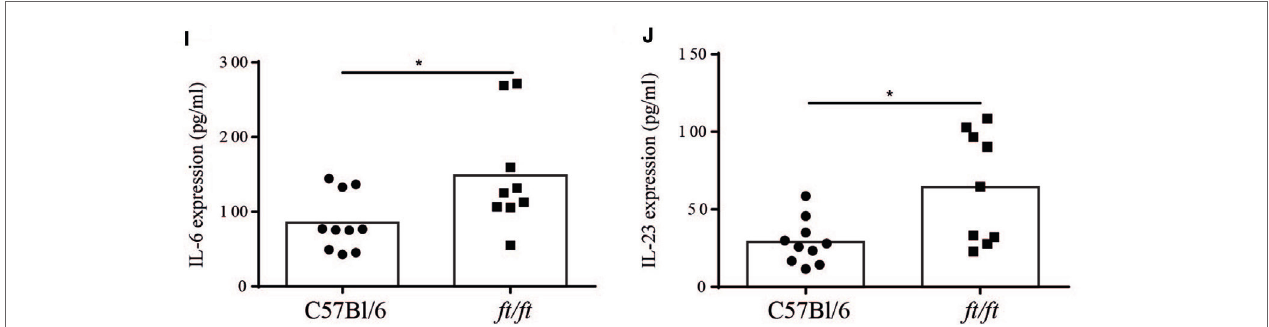
FigUre 5 | Altered TCR expression and cytokine expression in ft/ft mice. Representative histograms of (a) CD3 ε and (B) TCR γδ expression on thymocytes from 8 to 12 weeks old wild-type (WT) (dashed lines) and ft/ft (red filling) mice. Mean fluorescence intensity (MFI) of (c) CD3 ε and (D) γδ TCR expression. (e–h) Relative gene expression of IL1B , IL6 , IL23 , and TGFB1 in the thymi from ft/ft and WT mice. The Ct-values of the specific gene transcription were normalized to the transcription of GAPDH. (i,J) Concentrations of IL-6 and IL-23 in thymic lysates from ft/ft and WT